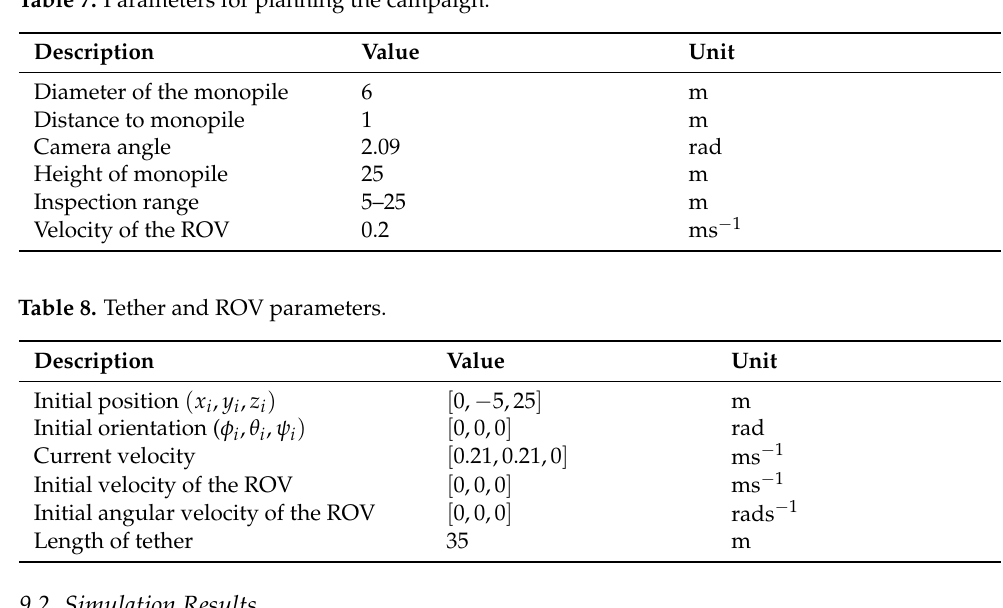
Figure 12. Trajectory of the inspection campaign. The vertical lines are the inspection trajectory and the horizontal lines are the reference change. Table 7. Parameters for planning the campaign.